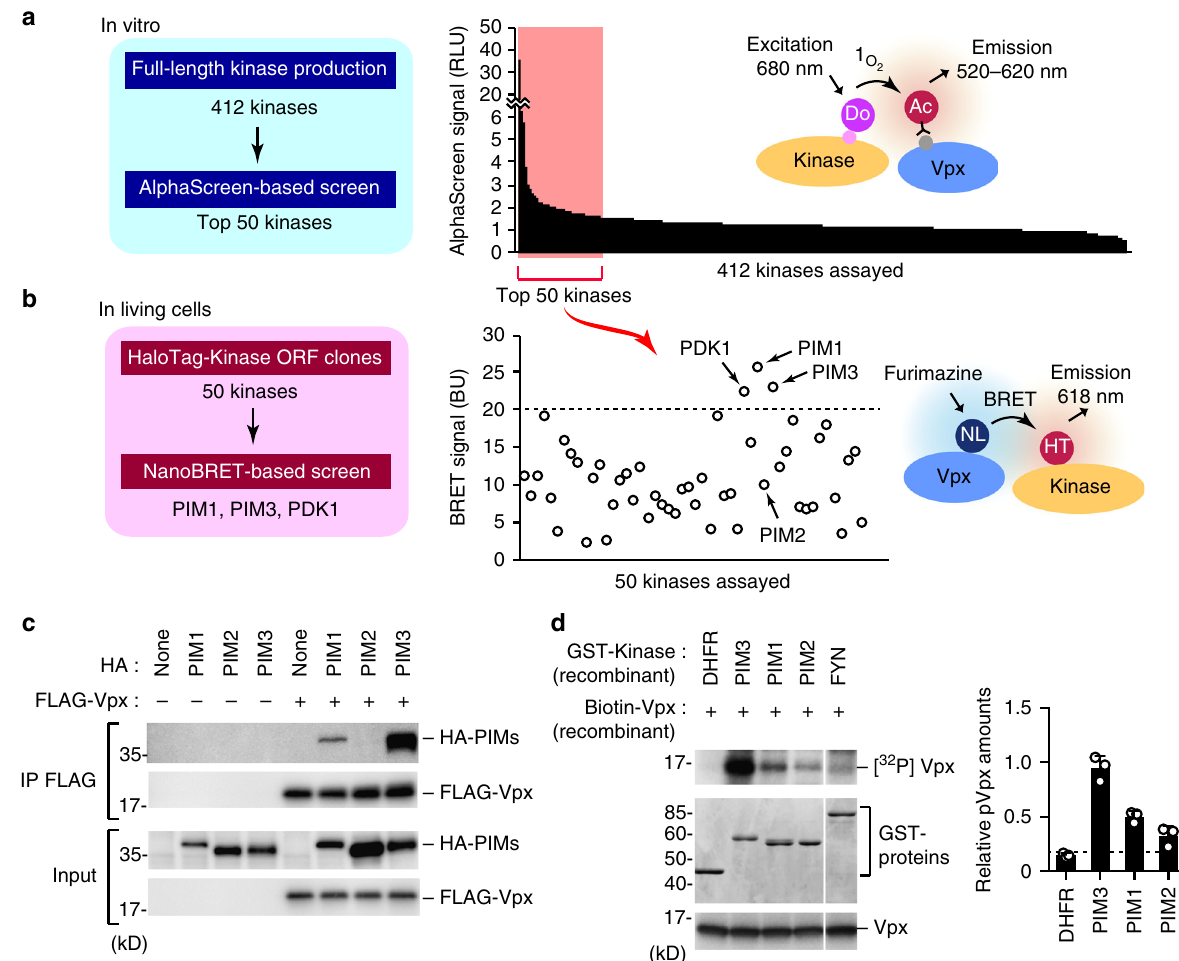
Fig. 1 Identi fi cation of protein kinases responsible for Vpx phosphorylation. a Schematic representation of the AlphaScreen-based luminescent system to screen for human kinases that interact with HIV-2 Vpx in vitro. Streptavidin-coated donor beads (Do) and anti-FLAG antibody conjugated to protein A acceptor beads (Ac) were mixed with recombinant Vpx and kinase proteins, respectively, and AlphaScreen signals were detected if the two proteins were close each other (See Supplementary Fig. 1 for detail procedure). When a relative light unit per cutoff (RLU/Co) ratio of ≥ 1.5 was set as the threshold, 50 kinases were identi fi ed as potentially Vpx-interacting proteins. The AlphaScreen was performed in duplicate for each sample. b NanoBRET-based secondary screen to identify Vpx-interacting proteins in living cells. HEK293 cells were co-transfected with NanoLuc (NL)-conjugated Vpx and HaloTag (HT)-fused kinase expression vectors, and then HT-618 ligand and furimazine substrate were added to cells (see Supplementary Fig. 2 for detail procedure). When a relative BRET signal of ≥ 20 was set as the threshold, three kinases were identi fi ed as Vpx-interacting proteins in living cells. The NanoBRET was performed in duplicate for each sample. c Immunoprecipitation analysis for PIM family kinases to interact with Vpx. HEK293 cells were transfected with HA-tagged PIM kinases and FLAG-Vpx. Forty-eight hours after transfection, cells were lysed and then immunoprecipitated with anti-FLAG antibody followed by immunoblot analysis. d Biochemical approach for detecting the phosphorylation of Vpx by PIM family kinases. Recombinant biotinylated Vpx and indicated kinase proteins (GST-tagged) were produced in a wheat-germ cell-free system, and then mixed and incubated with 32 P- labeled adenosine 5 ′ -triphosphate. Mixtures were subjected to autoradiography (top) or immunoblotting with anti-GST antibody (middle) or anti-Vpx (bottom). Dihydrofolate reductase (DHFR) was used as a negative control. Bar graph indicates the percentage of phospho-Vpx in total Vpx, as determined by densitometry ( n = 3, mean ± s.d.). Source data are provided as a Source Data fi